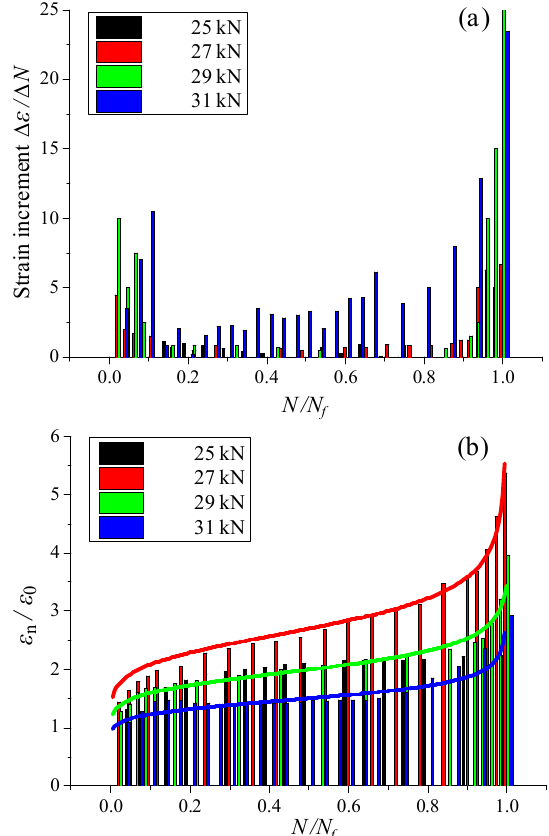
Figure 15. Evolution of strain characteristics for different static stress levels: ( a ) strain increment and ( b ) ε n / ε 0 . Table 8. Strain evolution equation fitting